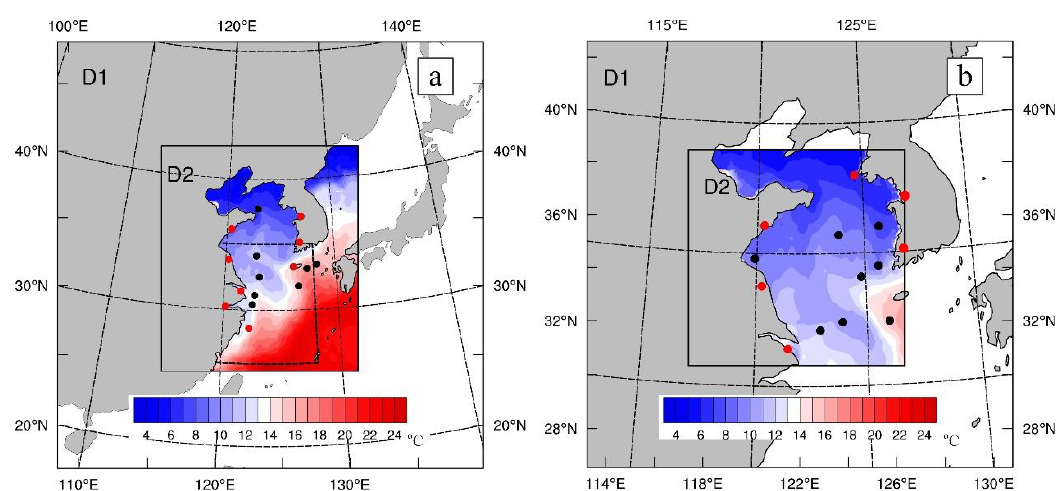
Figure 2. Weather Research and Forecasting (WRF) domains for the cases: ( a ) C-09 and ( b ) C-14. Colors show sea surface temperature (SST) within the D2 domains, and the red and black dots respectively locate radiosonde stations and ship measurement sites. The sea area surrounded by thick dashed lines and coastlines in D2 of ( a ) is used for evaluating forecasted sea surface winds later.